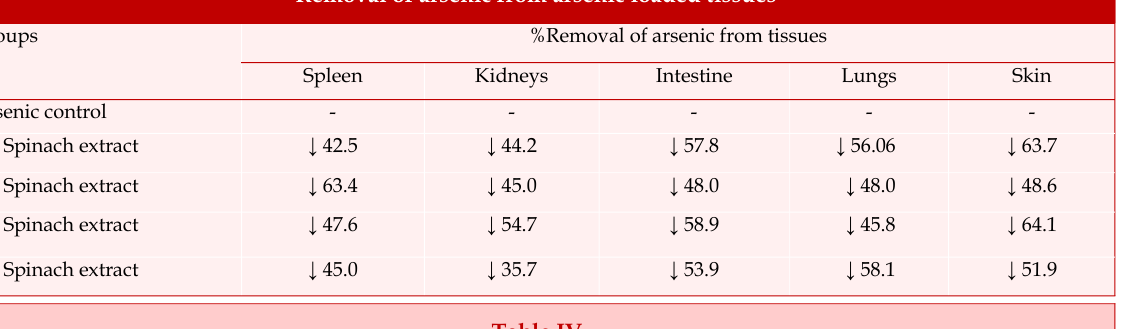
Removal of arsenic from arsenic loaded